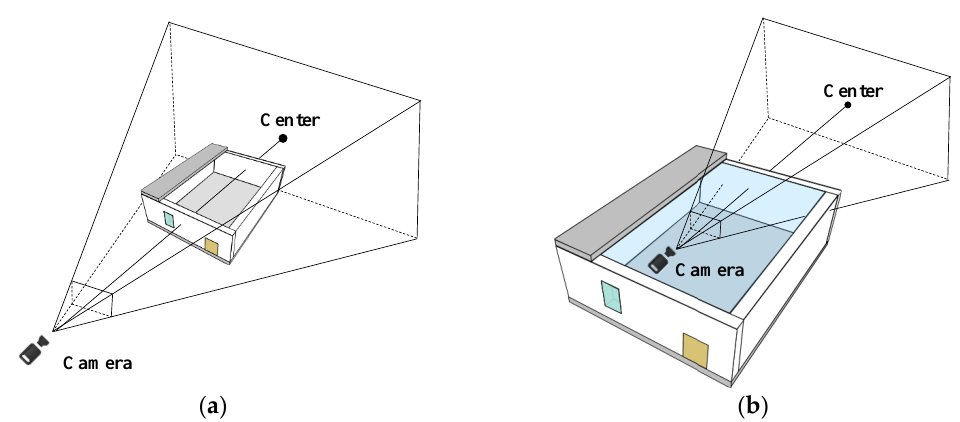
Figure 4. Intersection of the center ray and building. ( a ) Outdoor and ( b ) indoor scenes. Algorithm 1. Semantic-based scheduling algorithm for indoor scenes in 3D GIS